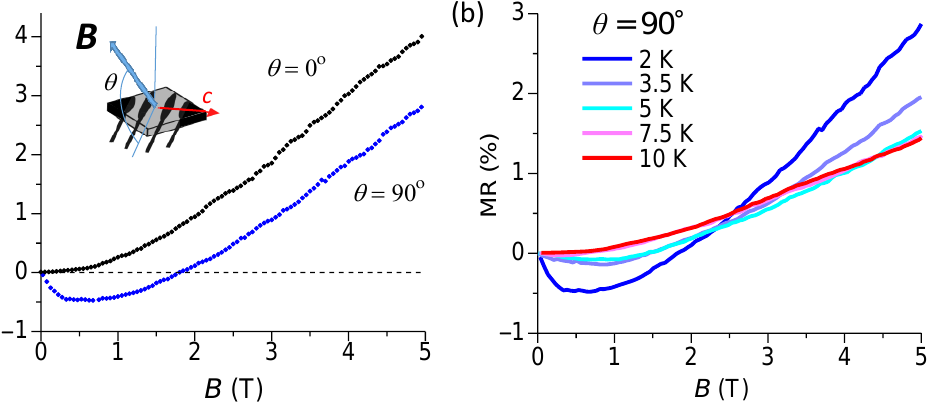
Figure 5. ( a ) The MR (current along c -axis) of κ -BO2 (sample #1) at 2 K under magnetic field B par- − − allel ( θ = 0°) and perpendicular ( θ = 90°) to the 2D layer. Clear negative MR was observed when θ = 90°. ( b ) The MR for the perpendicular field in the temperature range of 2 – 10 K.